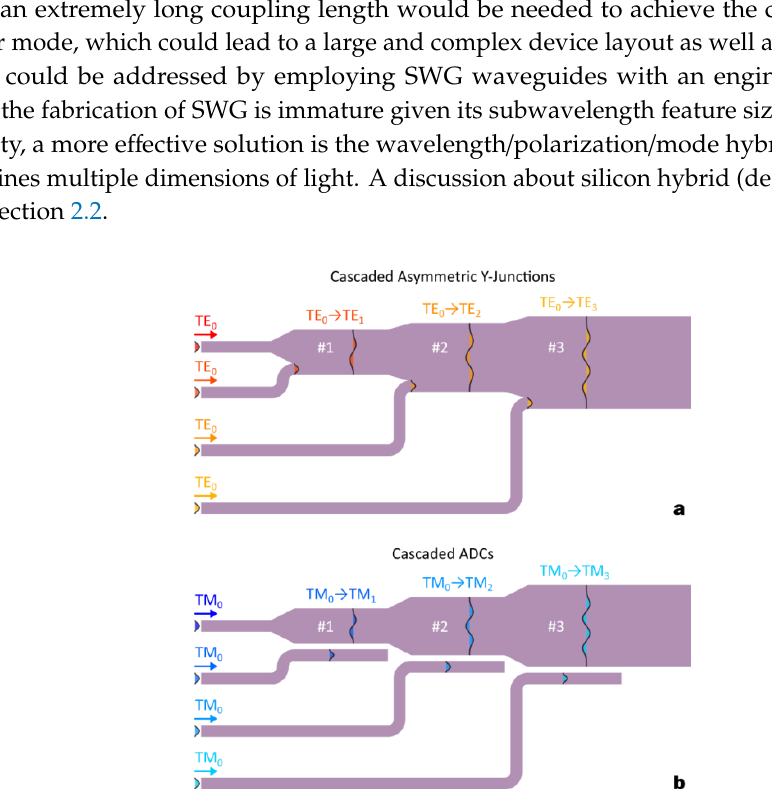
Figure 5. The schematics for the scalable silicon mode (de)multiplexers based on ( a ) cascaded asymmetric Y-junctions [75,76] and ( b ) cascaded ADCs [77]. Table 1. Summary of the reported silicon mode (de)multiplexers.